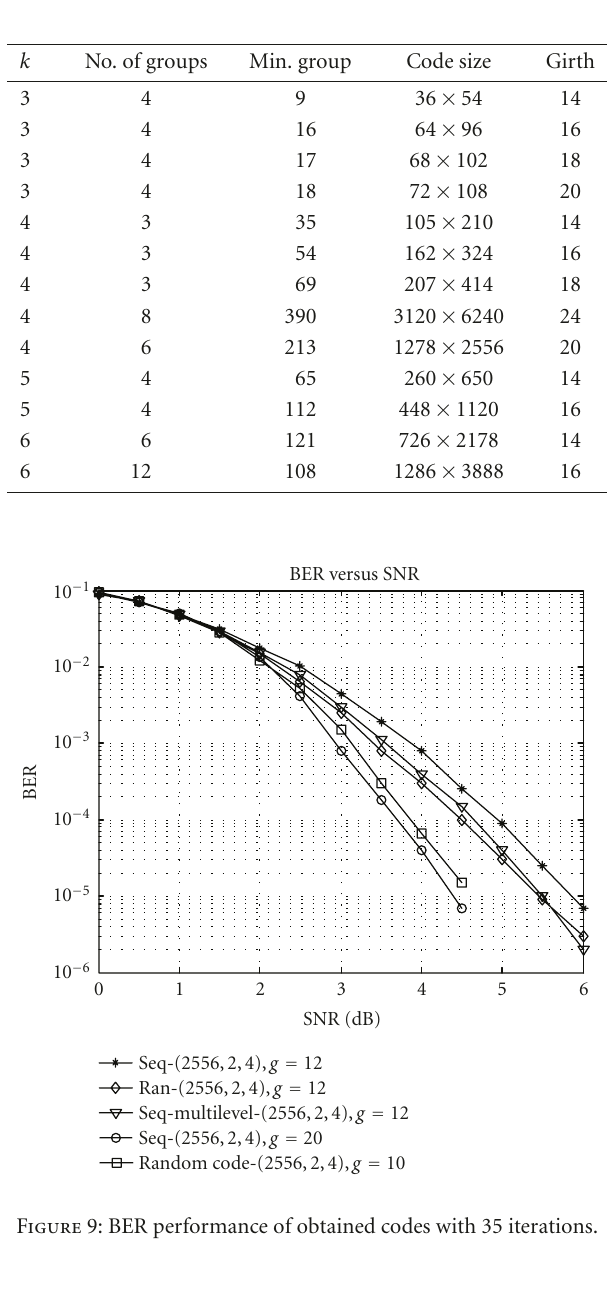
Table 3: Code sizes of girths larger than twelve using a sequential search.